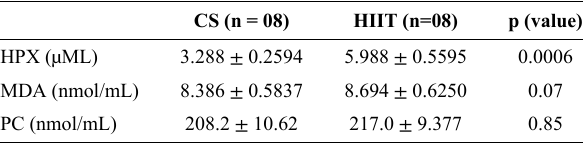
carbonylated proteins (PC) in cardiac tissues from